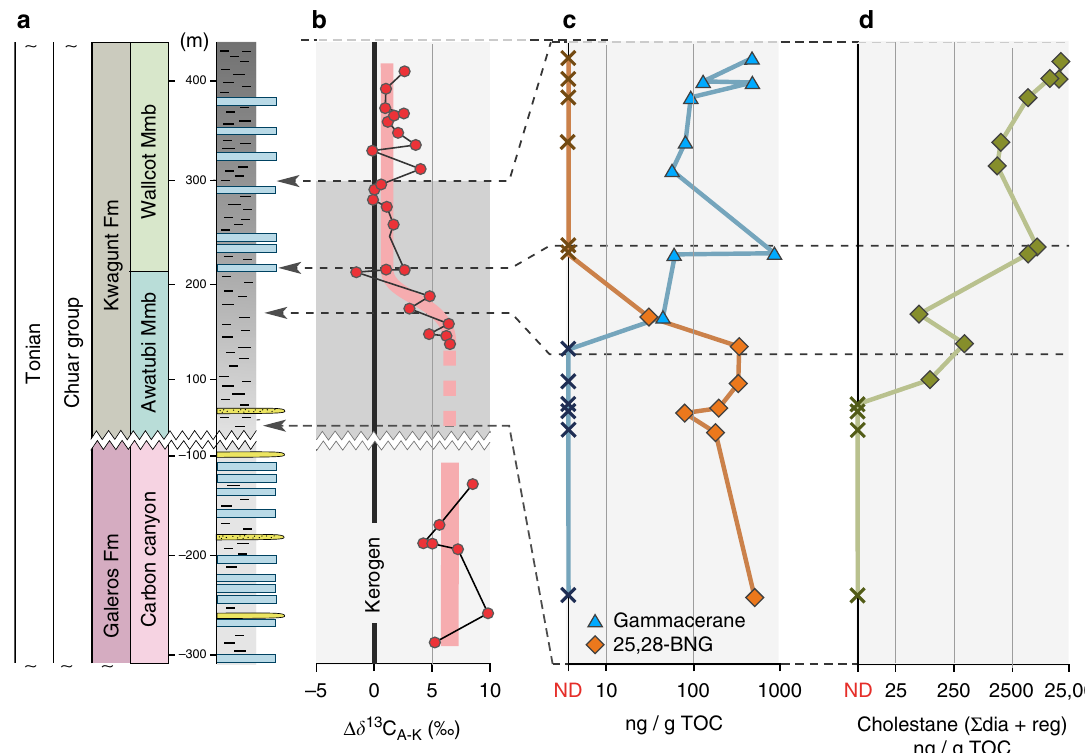
Fig. 4 Heterotrophy, community change and 25,28-bisnorgammacerane. a Stratigraphy of the ~750 Ma Chuar Group; b the change observed in the δ 13 C offset between kerogen and alkanes (noted as Δ δ 13 C A-K ; here normalised to kerogen) parallels the c anticorrelative transition that is observed between gammacerane (blue triangles; ND not detected), a molecular fossil derived from tetrahymanol producing ciliates, and 25,28-bisnorgammacerane (25,28- BNG; orange diamonds); and d an increase in eukaryotic-derived cholestane (ng/g TOC; ∑ dia + reg; green diamonds) indicating a shift in the composition of the primary producing community 36 and the intensity of heterotrophic reworking 37